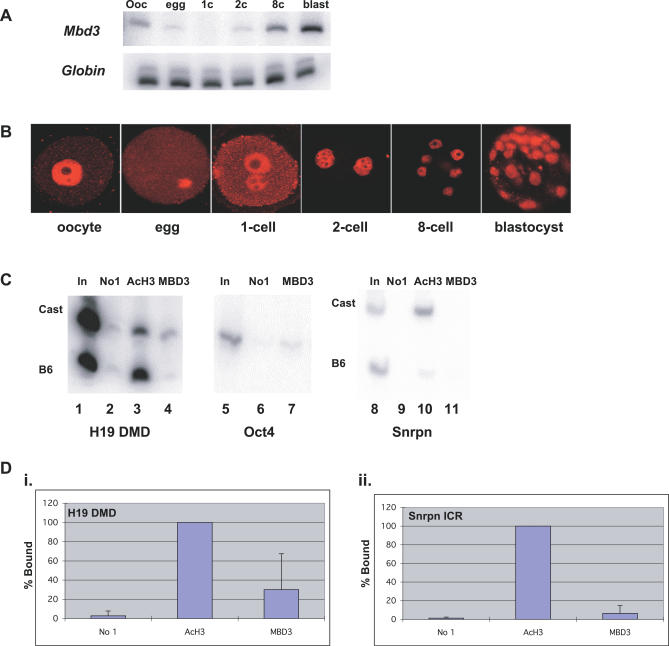
Mbd3 RNA and Protein Patterns in Oocytes and Preimplantation Embryos(A) Mbd3 and globin primers were used to amplify Mbd3 and exogenously added globin RNA from oocyte and preimplantation embryo cDNA samples. Mbd3 RNA was normalized against exogenously added globin RNA.(B) Immunocytochemistry using an anti-MBD3 antibody and a Cy3 secondary antibody showed that MBD3, a nuclear protein, is also maternally contributed to oocytes and follows a pattern similar to that of Mbd3 RNA, increasing to high levels at the blastocyst stage.(C) Chromatin immunoprecipitation (ChIP) from hybrid ES cells at the H19 DMD, Oct4, and Snrpn loci with acetylated H3 antibody (AcH3) (Lanes 3 and 10) and MBD3 antibody (Lanes 4, 7, and 11). The H19 DMD and Oct4 are precipitated with the MBD3 antibody. Input chromatin (Lanes 1, 5, and 8) and no primary antibody (Lanes 2, 6, and 9) are included as positive and negative PCR controls. In the experiment presented here, 65% of the chromatin associated with the MBD3 antibody was from the paternal allele (C).(D) Quantitative real-time PCR was conducted using primers specific to the H19 DMD (i) or to the Snrpn imprinting control region (ii) for antibody-precipitated samples and no primary antibody (No 1) controls. The average percentage (+/− standard deviation) of bound material for three or more chromatin preparations is shown. The AcH3 results were set at 100% and the other values were normalized to the AcH3 results. A significant enrichment of MBD3 at the H19 DMD was evident when compared with the no-primary control (p < 0.05), but this enrichment was not observed at the Snrpn imprinting control region (p = 0.12). There was a significant enrichment for AcH3 histones at both loci (p < 0.01).